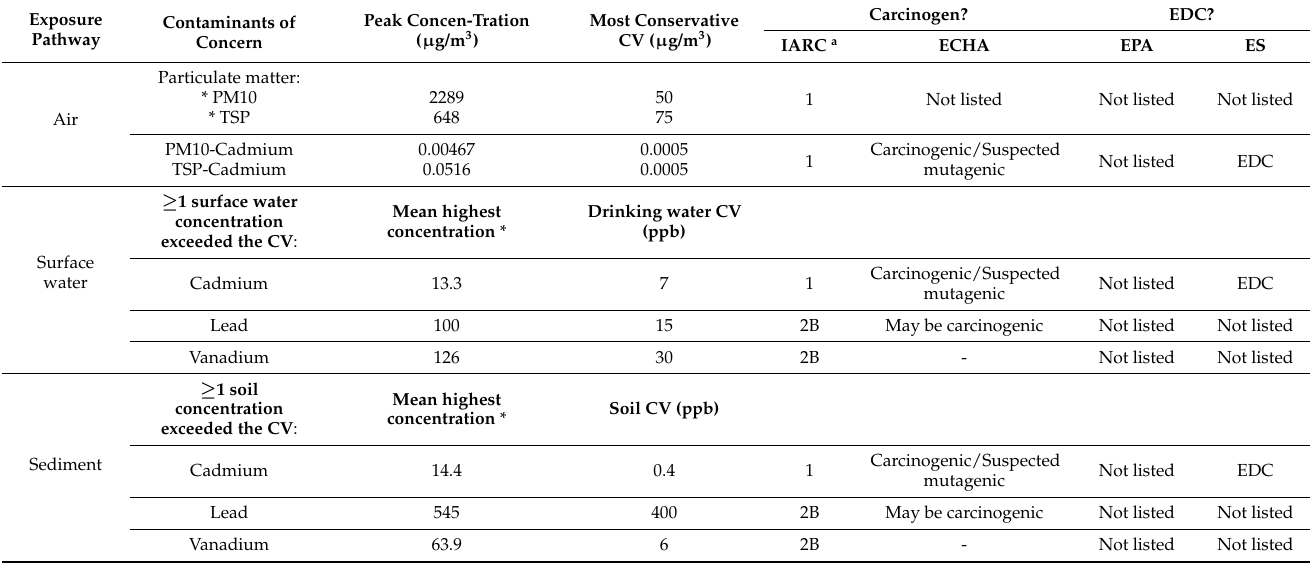
Table 1. Information on environmental risk factors associated with thyroid function/cancer from the Fresh Kills Landfill. Exposure Contaminants of Pathway